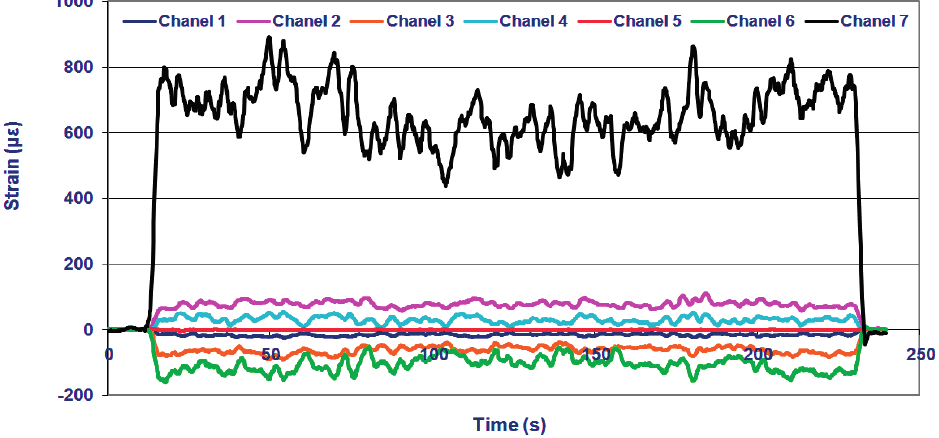
Figure 5. Strains ( με ) recorded in the experimental test in the field with loam texture (field 1), at a forward speed of 7 km/h and an application depth of 0.17